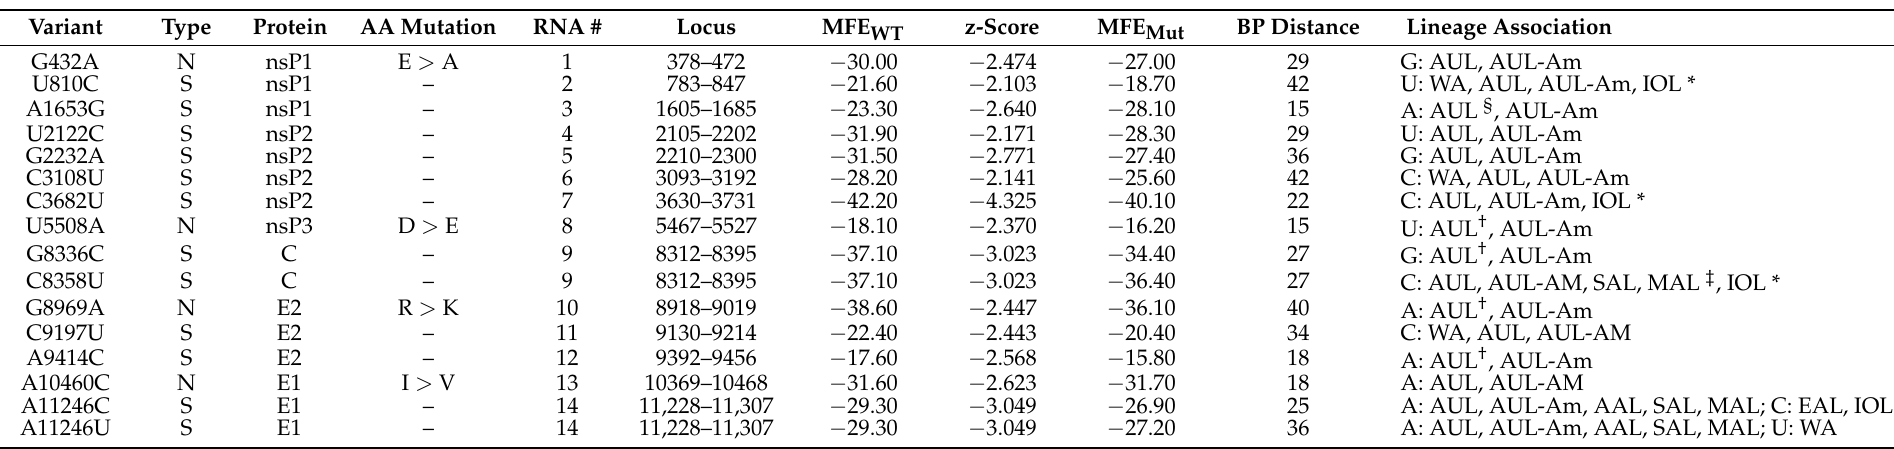
Table 3. Lineage-specific single-nucleotide mutations that modulate the fold of locally stable RNA elements in the CHIKV genome, computed for the reference strain of our Nextstrain build (accession KT327163.2). A total of 16 SNVs are overlapped by 14 locally stable RNAs. The Type column indicates whether a SNV induces a synonymous (S) or non-synonymous (N) mutation at the amino acid level. Amino acid changes are listed for Type N mutations in the AA mutation column. The Locus column lists global coordinates of locally stable RNAs in the reference strain. The minimum free energy (MFE) values for wild-type (WT) and mutant (Mut) are given in kcal/mol. The base-pair (BP) distances are computed between MFE structures of WT and Mut. * Subclade. § Isolates collected from 1983 onwards. † Isolates collected from 2006 onwards. ‡ Isolates collected from 2019